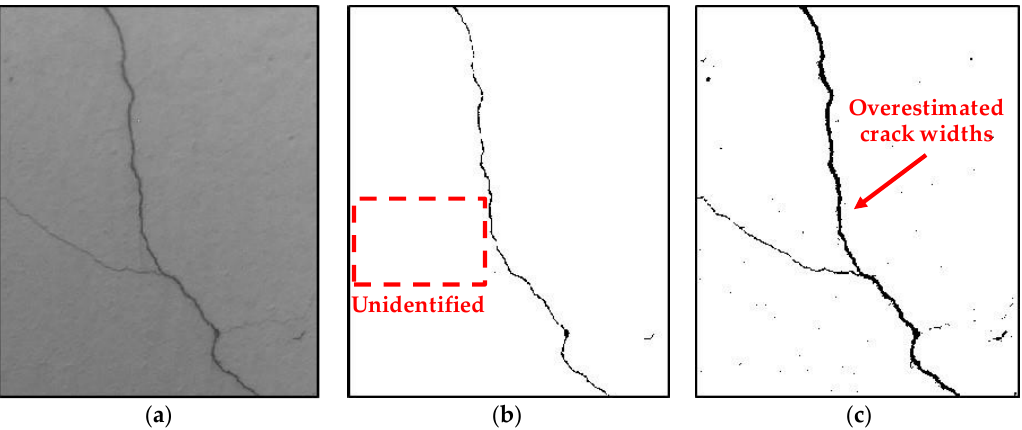
Figure 3. Binarization result of Sauvola’s method from different window sizes and sensitivities: ( a ) original grayscale image; ( b ) 80 × 80 window and sensitivity of 0.3 (Some cracks are unidentified); and ( c ) 100 × 100 window and sensitivity of 0.1 (the crack width is overestimated).